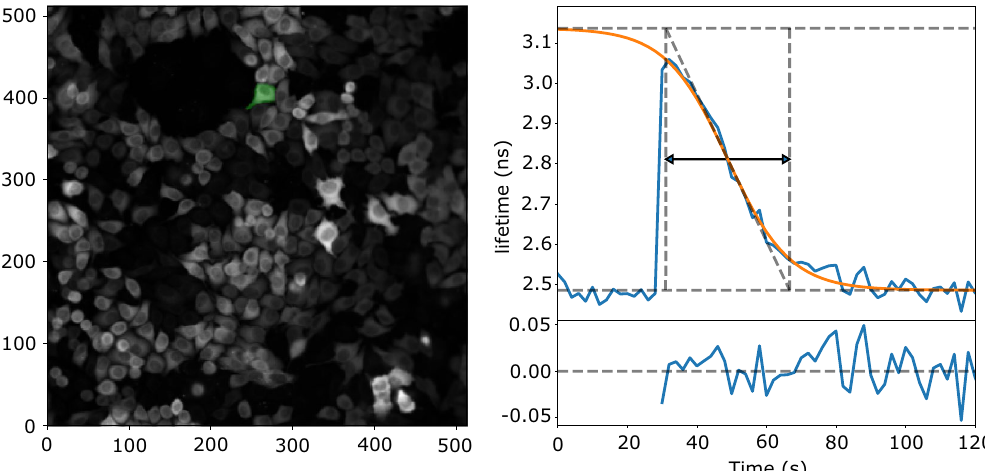
Figure 3. Changes in donor lifetime of the Epac-S H189 sensor upon uncaging of cAMP. The time trace (right) is from the green cell indicated in the left. Cells were imaged every 2 s and uncaging was at 25 s using a 200 ms flash of UV light. Note quick degradation of cAMP by PDEs back to baseline levels. Orange line shows the logistic function fitted to the data. Fit parameters are indicated by dashed lines: minimum and maximum lifetime (horizontal lines), maximum slope (diagonal line); vertical dashed lines indicate the intersection between maximum slope and min/max lifetime. The reported breakdown time (black arrow) is the time between the vertical two lines. The lower right panel shows the fit